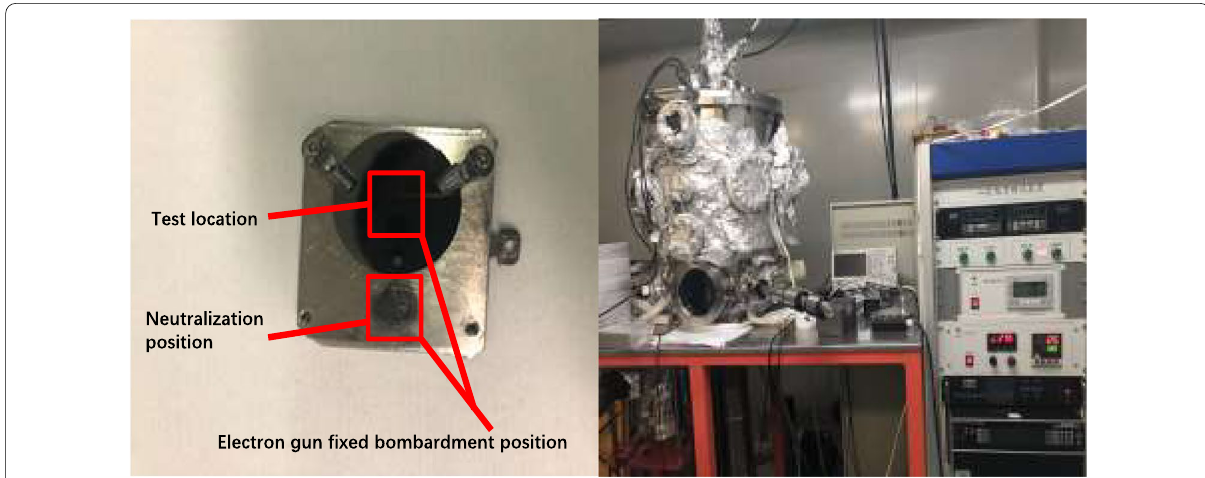
Fig.6 Photographs of the sample, the sample stage, and the secondary electron emission coefficient test